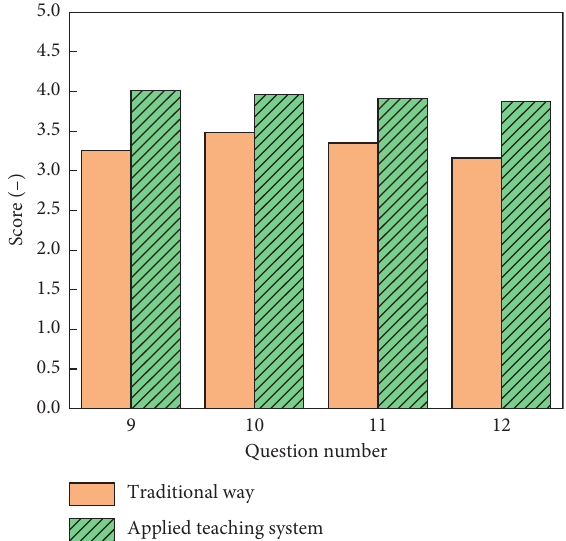
Figure 12: The scores of I&P teaching acceptance.